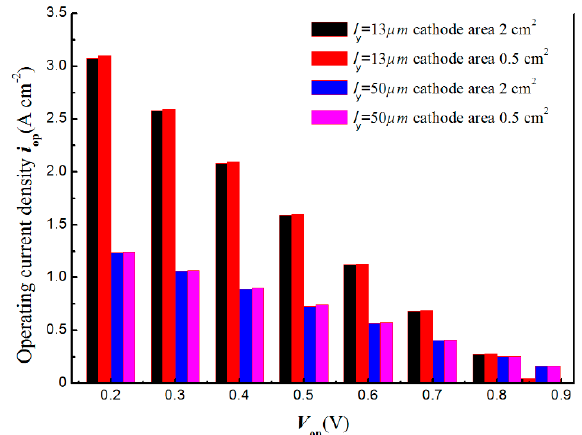
Figure 5. The effects of different A ca / A an on the button cell performances at 600 °C while increases the thickness of dense electrolyte from 15 to 50 μ m .